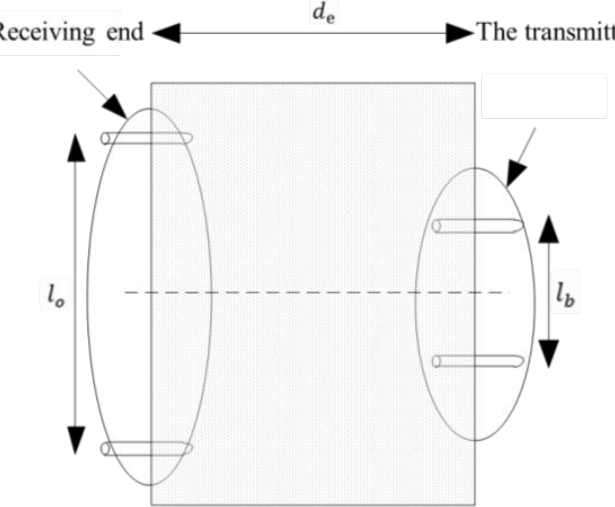
Figure 2. Schematic diagram of the transceiver electrodes.